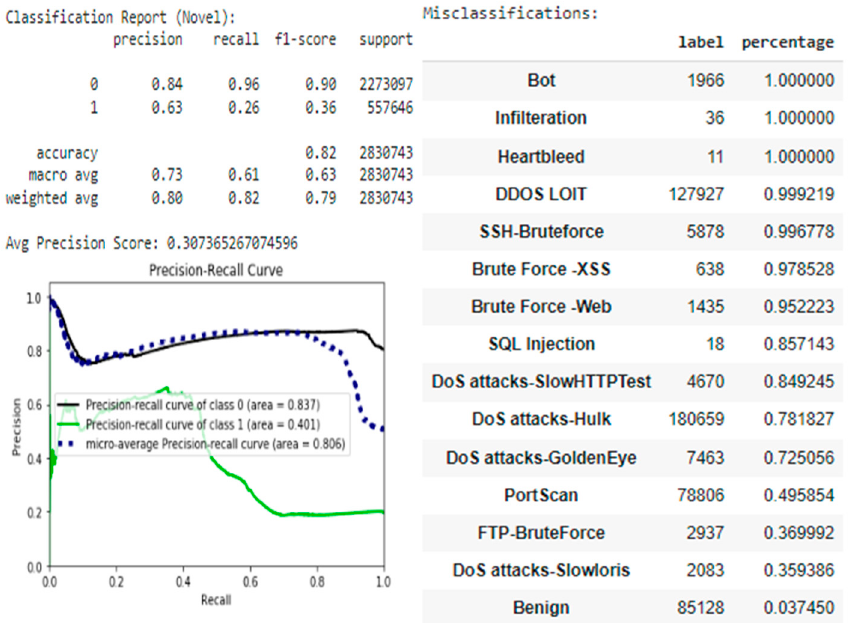
Figure 9. Combined estimator.